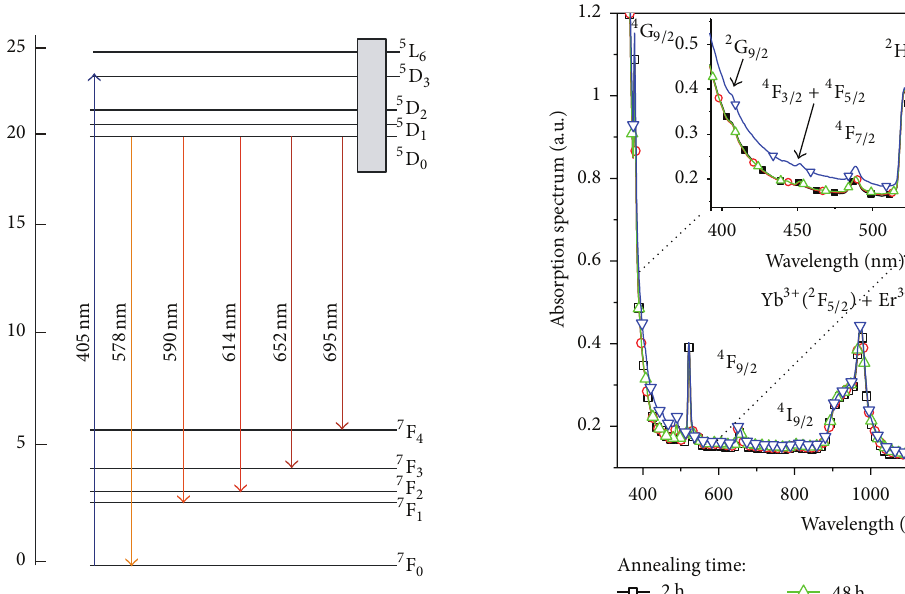
Figure 3: Simplified energy levels scheme of Eu 3+ ions with indication of the radiative transitions observed. The shaded area indicates the position of the localized surface plasmon band [1].